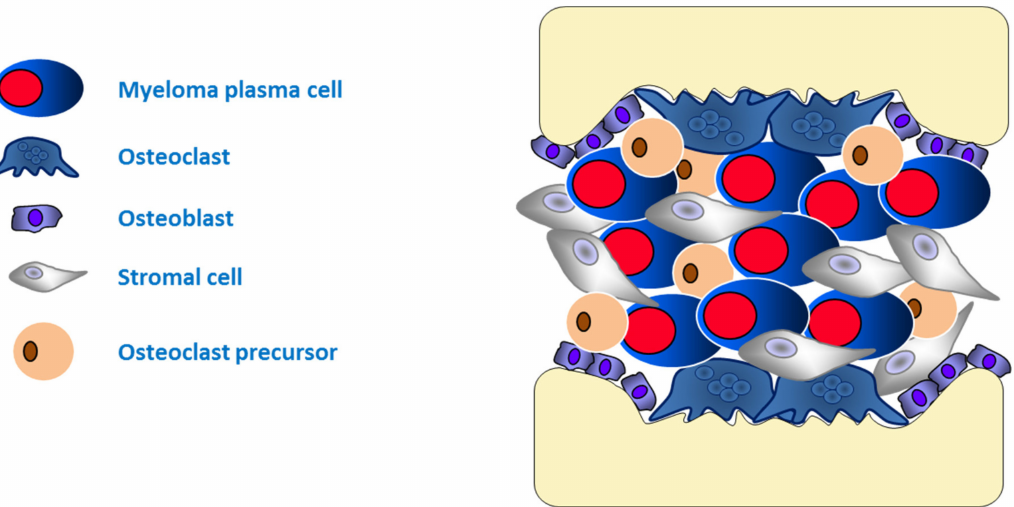
Figure 2. The “osteoblastic niche”. In the pathologic BM, resident macrophages and plasma cells induce the activation of osteoclasts and osteoclast precursors di ff erentiation to assemble, with osteoblasts and the other subtypes of stromal cells, the osteoblastic niche in which MM plasma cells are stimulated to proliferate and survive, and are protected from the aggression of anti-myeloma drugs and the immune